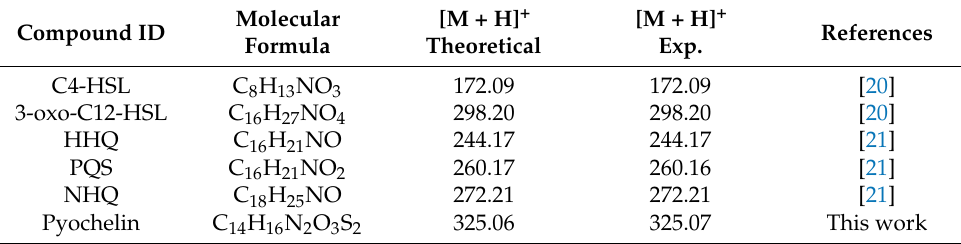
Figure 3. MSI images of N -acyl-homoserine lactone quorum sensing metabolites produced by biofilms P. putida 6157 grown for 6, 12, 24, and 48 h. Table 1. N -acyl-homoserine lactones and quinolones observed in P. putida 6157